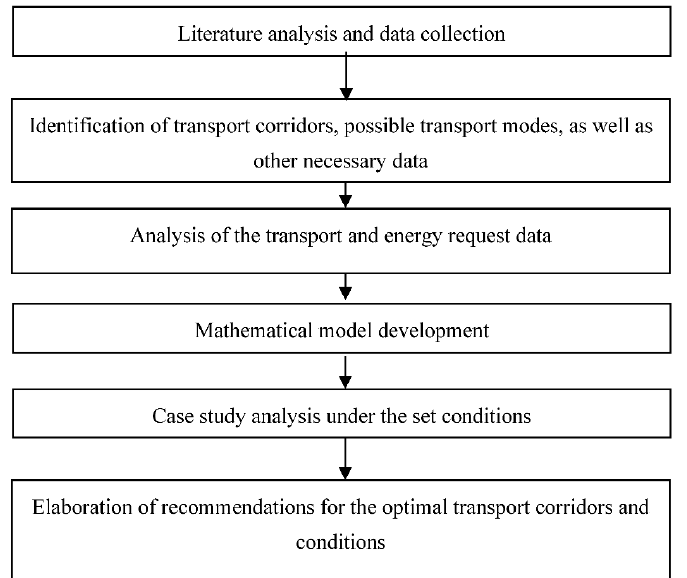
Figure 1. The algorithm of the research methodology.